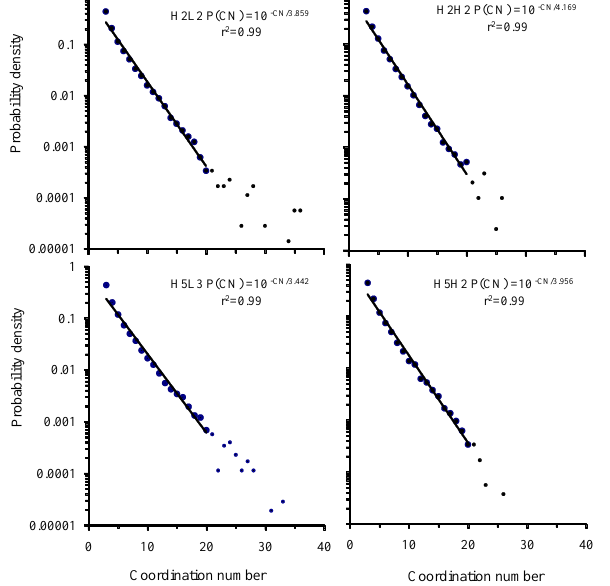
Figure 3. Probability density distributions versus pore volume for Hamra 2.0 and 0.5mm aggregate treatments (H2 and H5) and low- and high-compaction treatments (L and H). Selected replicates are shown in the figure (last number in treatment name is replicate). The number within parentheses is the sample mean pore volume in cubic micrometers. The circle represents the average pore volume and the horizontal line indicates the standard deviation of the mean.